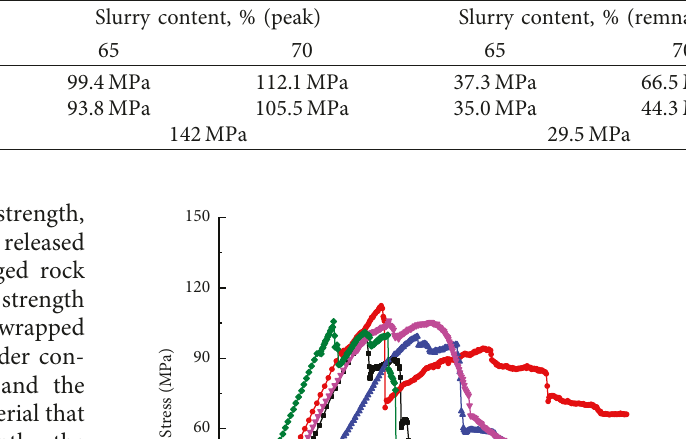
Table 2: Triaxial compression strength of RCTMC and RS specimens in these tests.